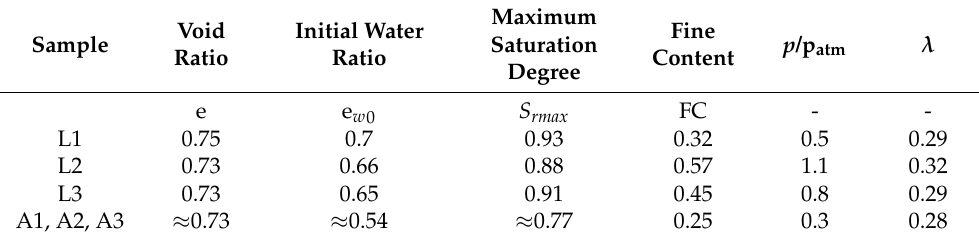
Table 2. Parameters of the van Genuchten’s model for the samples